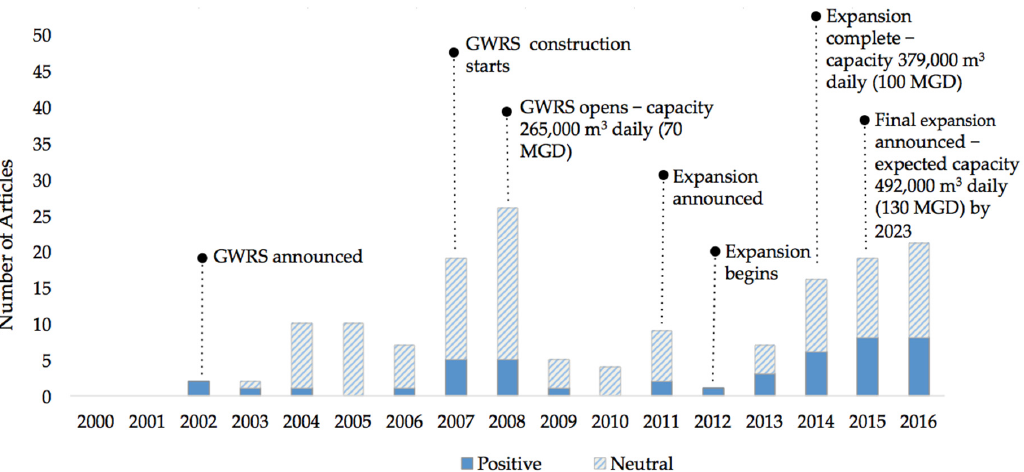
Figure 1. Number and tone of articles published per year with GWRS milestones, 2000–2016.